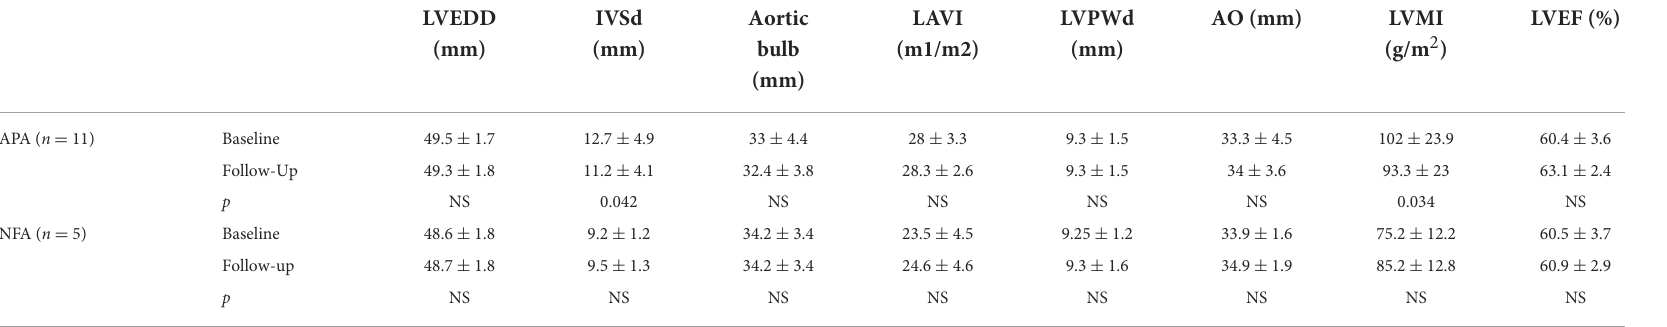
TABLE 4 Echocardiographic data of all patients at baseline compared to